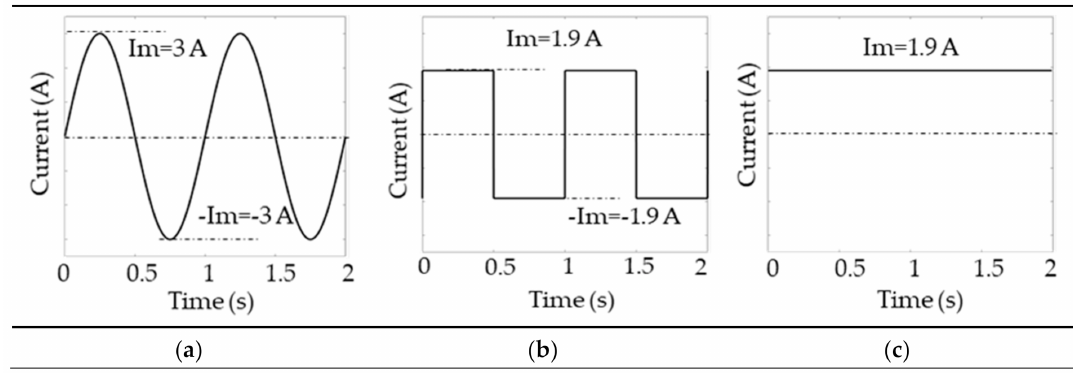
Figure 6. Current waveform diagram. ( a ) sin-AC, 1Hz; ( b ) S-AC, 1Hz; ( c )